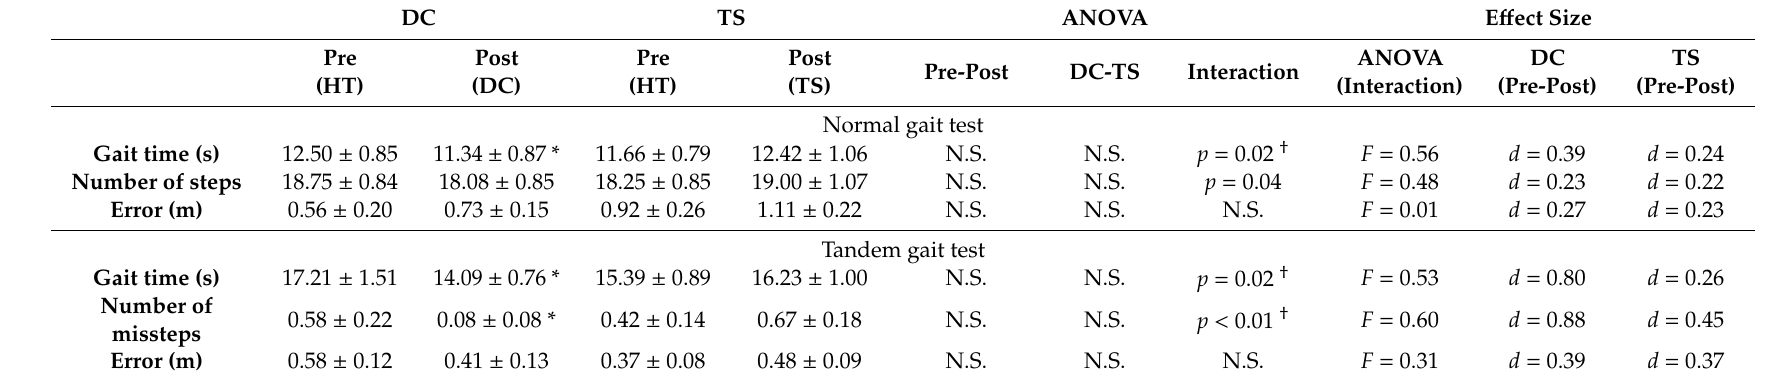
Table 1. Mean value of each variable during normal and tandem gait tests. Values are expressed as mean ± standard error of the